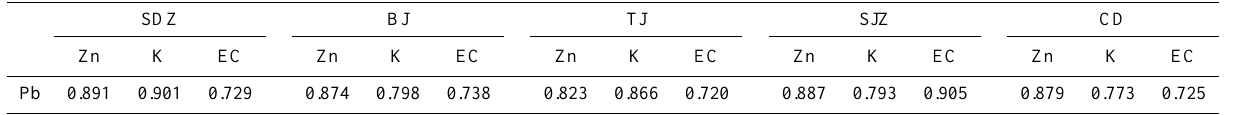
Table 8. Correlation coefficients between Pb and Zn, Pb and K, and Pb and EC.